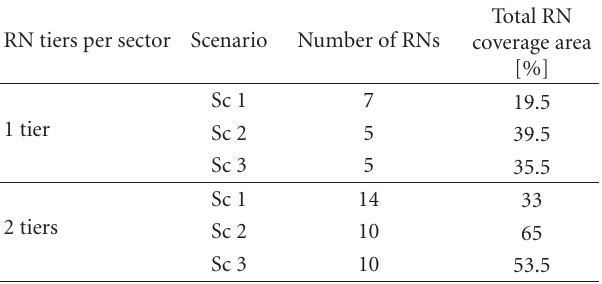
Table 3: RN Deployment Characteristics, ISD 500 m.